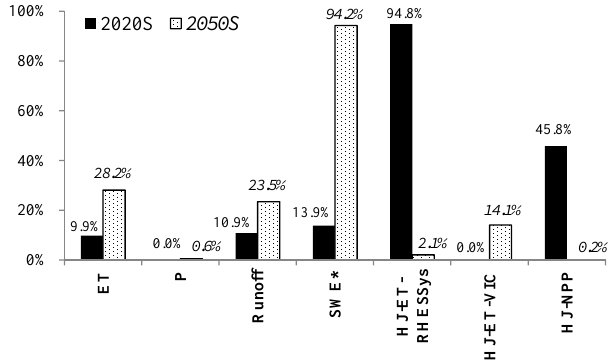
Fig. 4. Percentage of grid cells with significant differences ( p < 0 . 05) between the projected changes using BC and NBC climate data. Note: for 1 April SWE, the sample size is the number of grid cell that has a minimum of 25mm SWE on 1 April according to observed climate for the historical